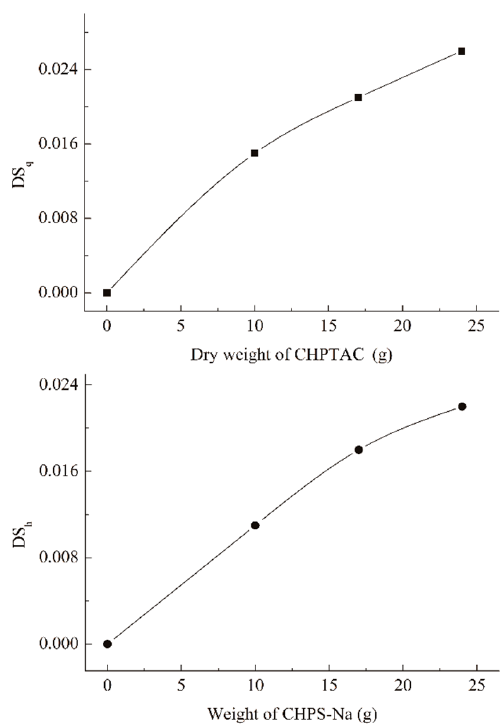
Figure 3. Degrees of substitution of starch modification, i.e., quaternization level (DS q ) and the hydroxypropylsulfonation one (DS h ) of OTS with N -(3-chloro-2-hydroxypropyl) trimethylammonium chloride (CHPTAC) and 3-chloro-2-hydroxy-1-propanesulfonic acid sodium salt (CHPS-Na), respectively.